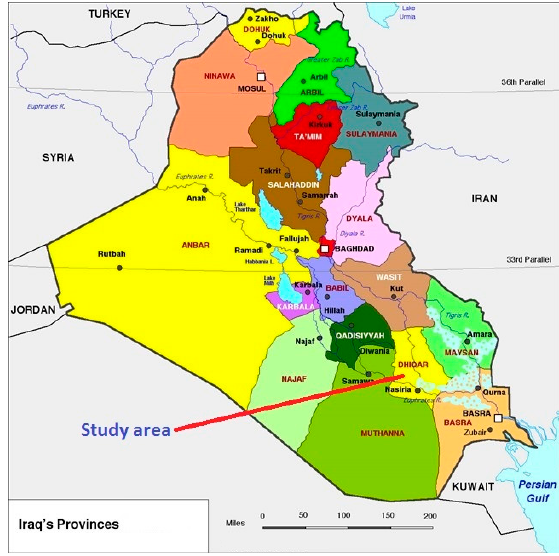
Figure 1. Dhi-Qar Province and its location in southern Iraq.